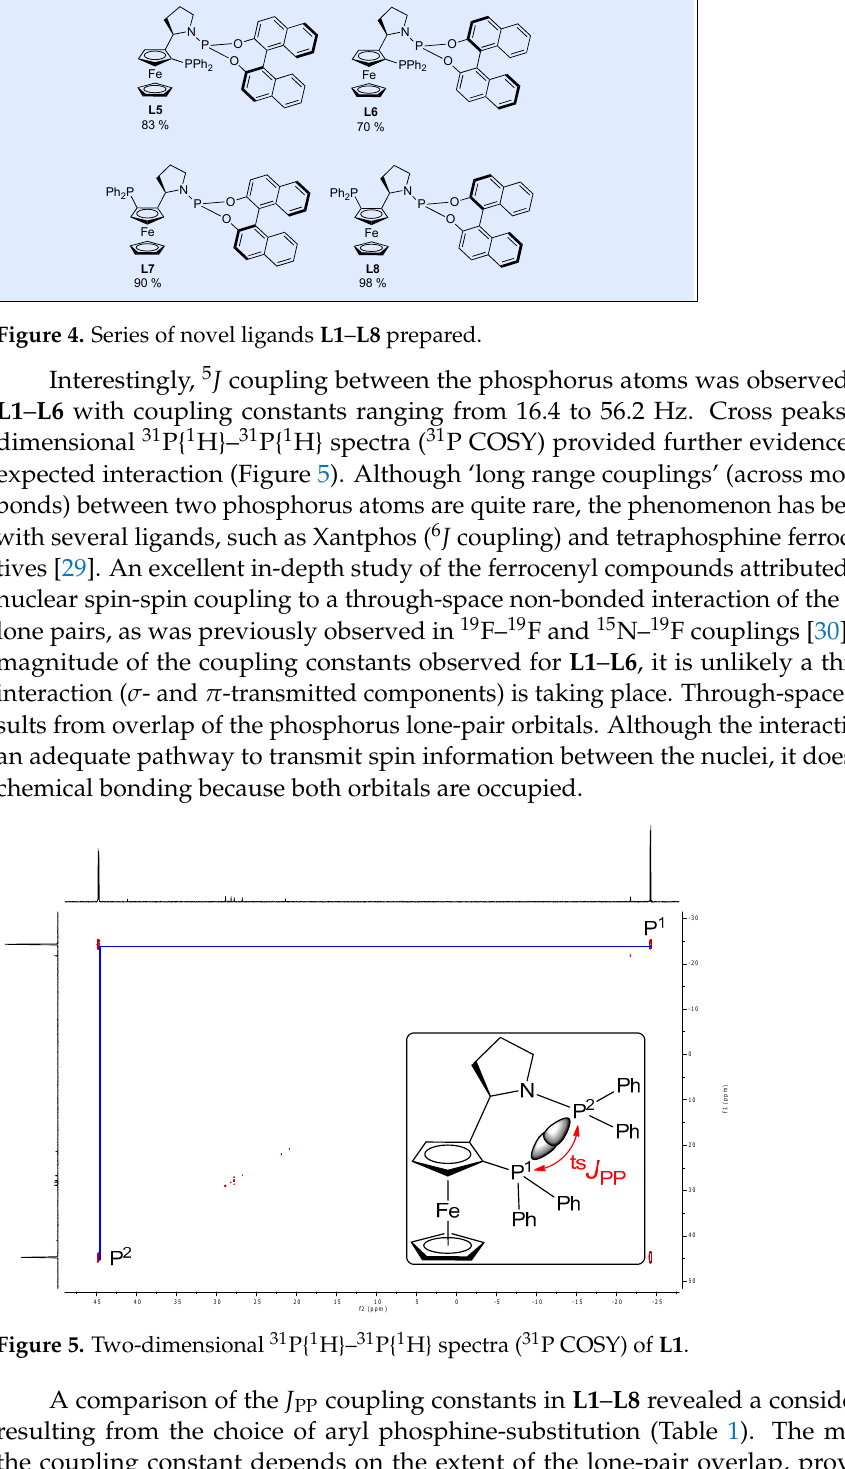
Figure 5. Two-dimensional 31 P{ 1 H}– 31 P{ 1 H} spectra ( 31 P COSY) of L1 . A comparison of the J PP coupling constants in L1 – L8 revealed a considerable effect resulting from the choice of aryl phosphine-substitution (Table 1). The magnitude of the coupling constant depends on the extent of the lone-pair overlap, providing some infor- mation on the P-P orientation and proximity in solution. No coupling was observed for L7 – L8 indicating the planar and central chirality of the ligand prohibit favorable align- ment of the lone pairs. These factors could provide useful information on the bite angle and play an important role in the future development and application of this class of lig- and. Table 1. Magnitude of the ts J PP coupling constants in L1 – L8 .